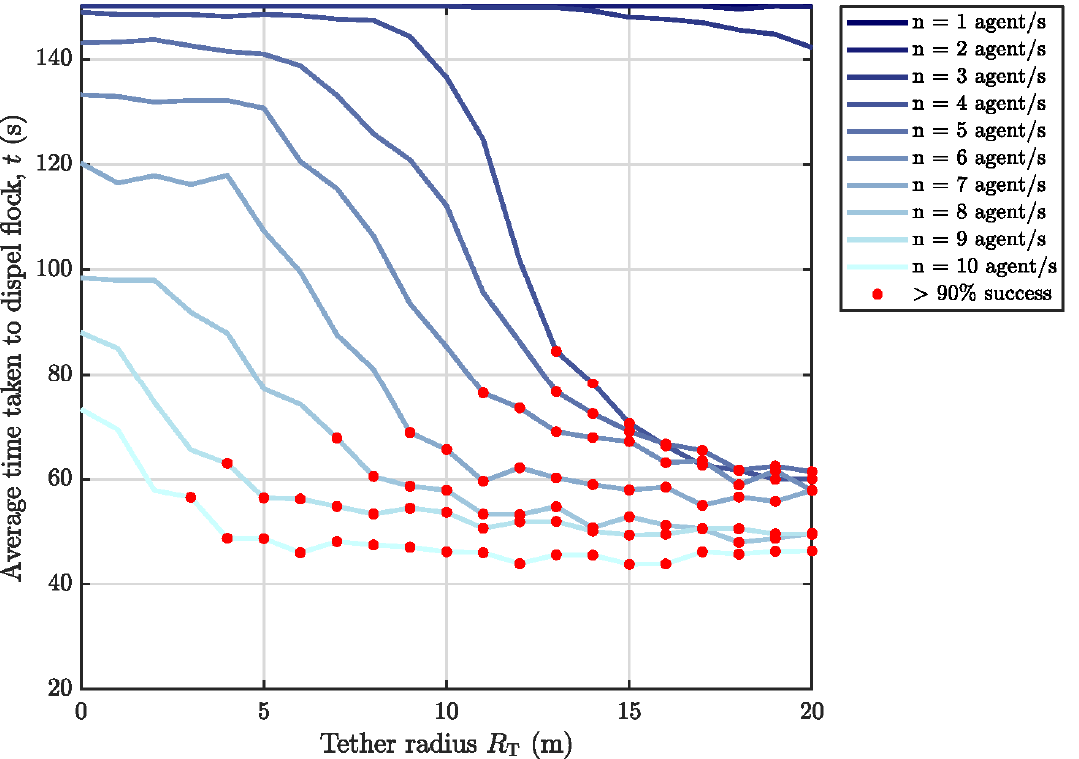
Figure A3. – Triple-target scenarios—time performance (darker lines indicate fewer agent numbers while red markers indicate data points whose average success rate is above the given threshold). Maximum agent speed 𝑣 max = 12 m/s.